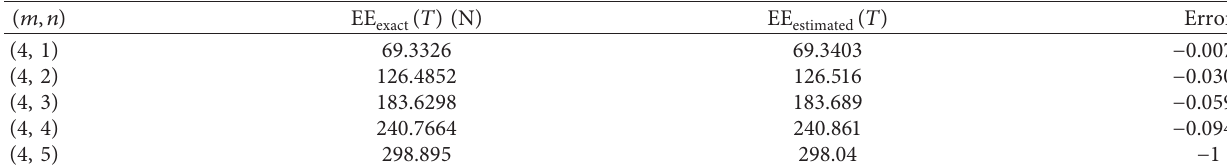
( T ) of the TUC estimated